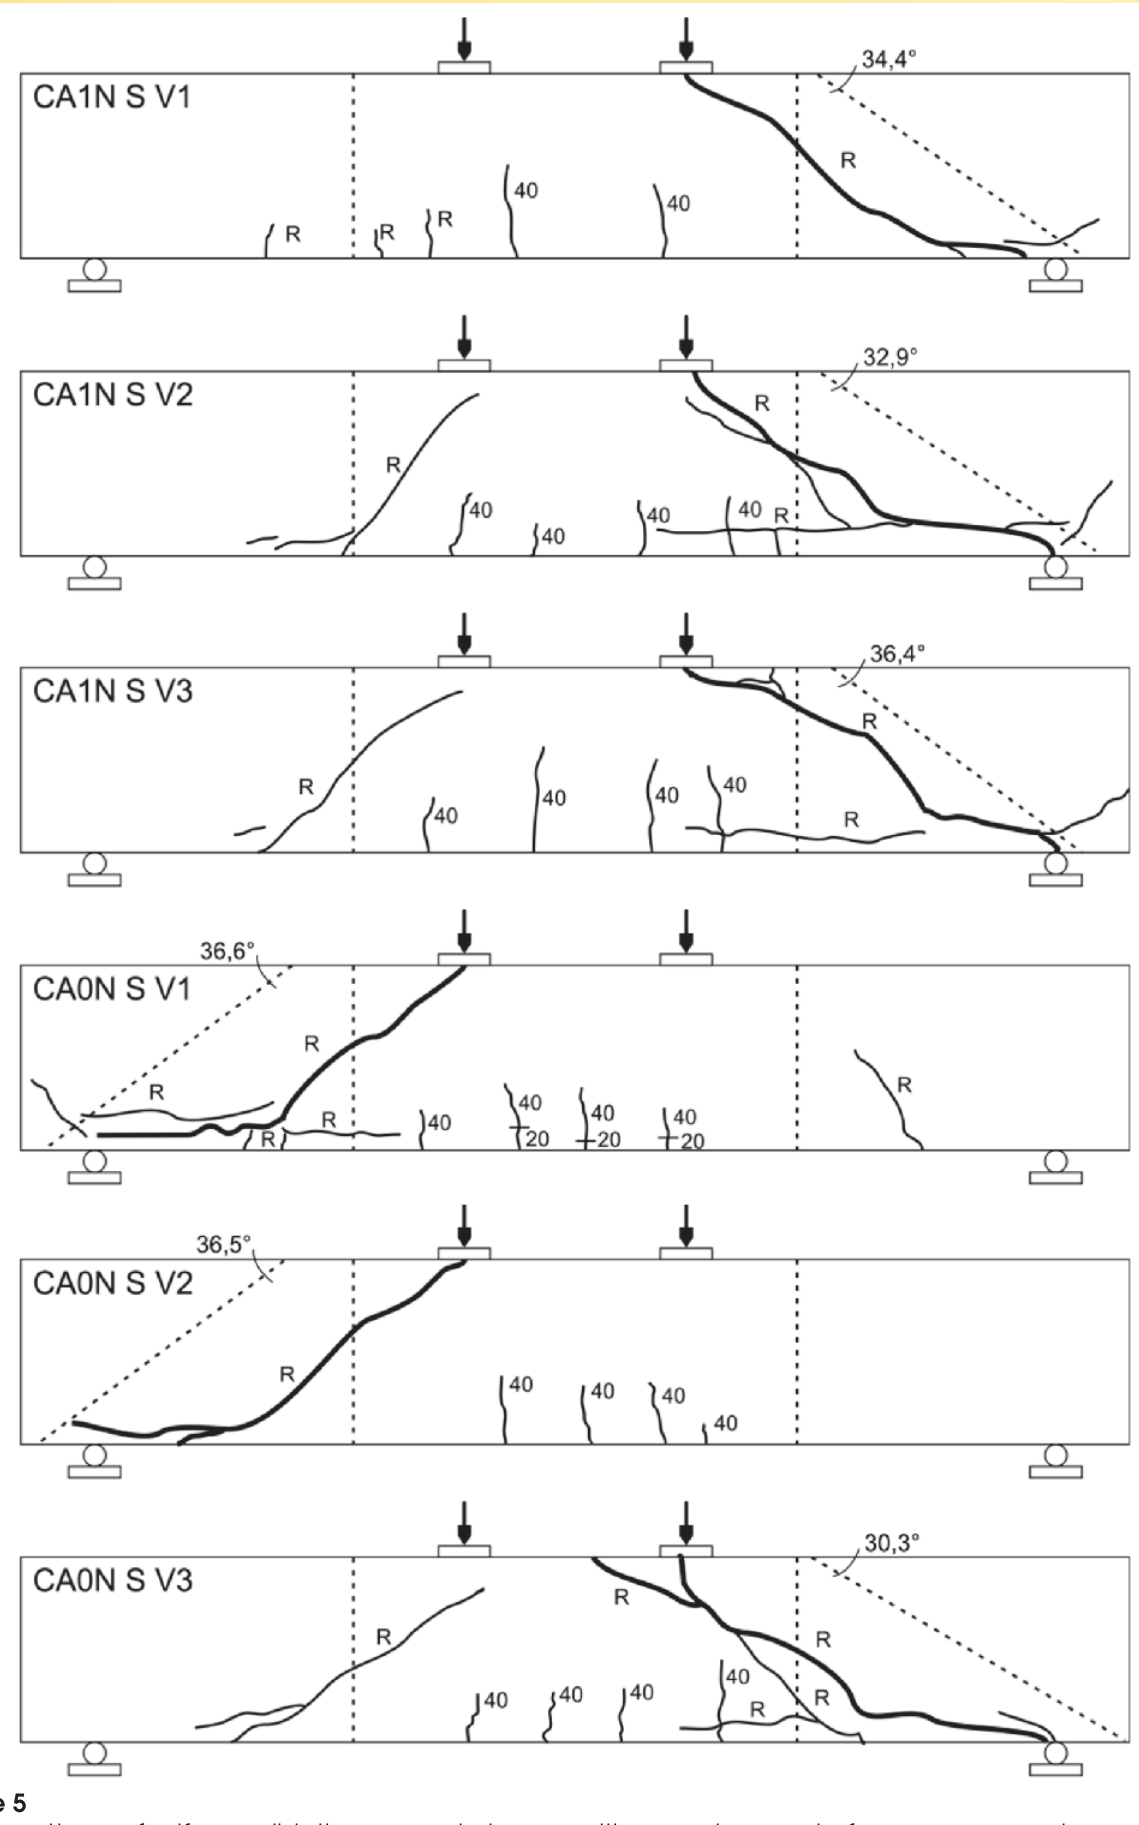
Figure 5 Crack patterns of self-consolidating concrete beams with normal amount of coarse